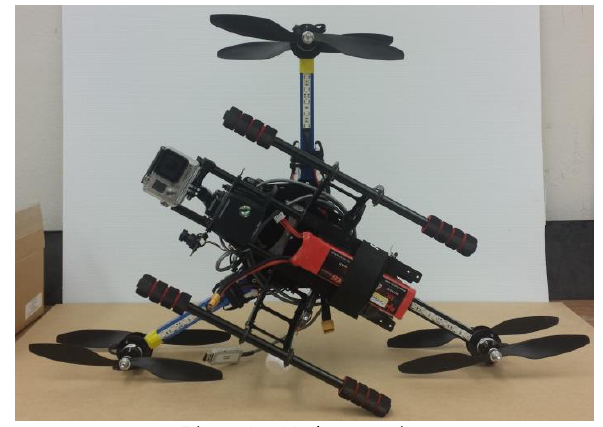
Figure 2.UAV bottom view